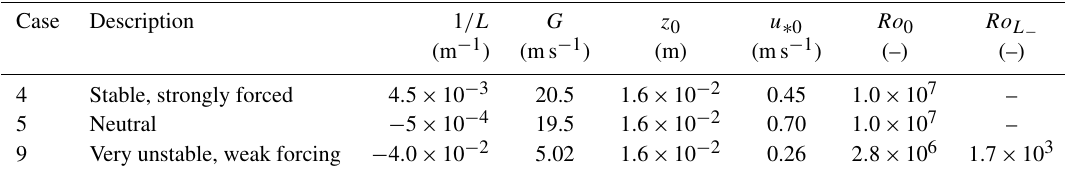
Table 3. ABL validation cases based on Peña et al. (2014).